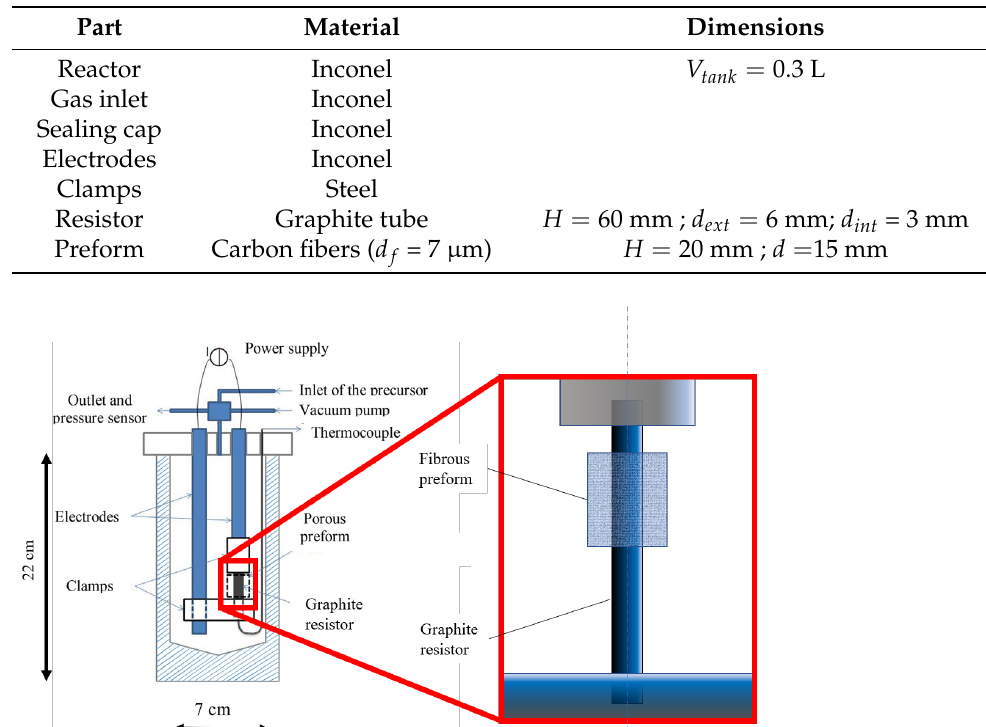
Table 1. Specifications of the experimental setup.